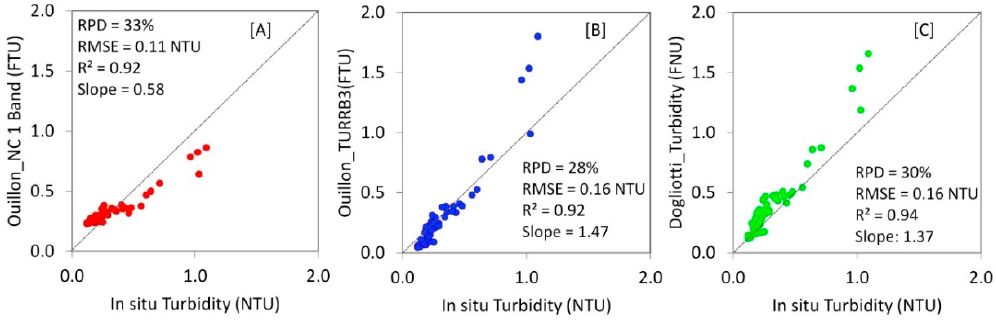
Figure 15. Turbidity estimated following Ouillon et al. [38] for New Caledonia ( A ) and “global” tropical coastal waters ( B ) and Dogliotti et al. [39] ( C ), compared to turbidity measured in situ (Number of samples = 48).